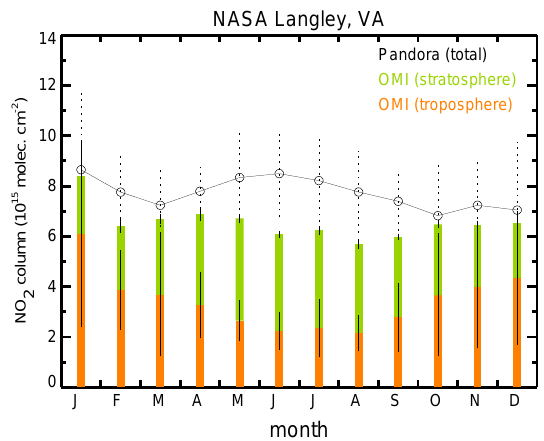
Figure 9. Monthly variation of total NO 2 columns at Hampton, VA for 2009–2012, as calculated from Pandora measurements (line with open circles) and OMI measurements (bars). OMI total NO 2 columns are separated into stratospheric (green bars) and tropo- spheric (orange bars) components. The bars represent the standard deviation of the